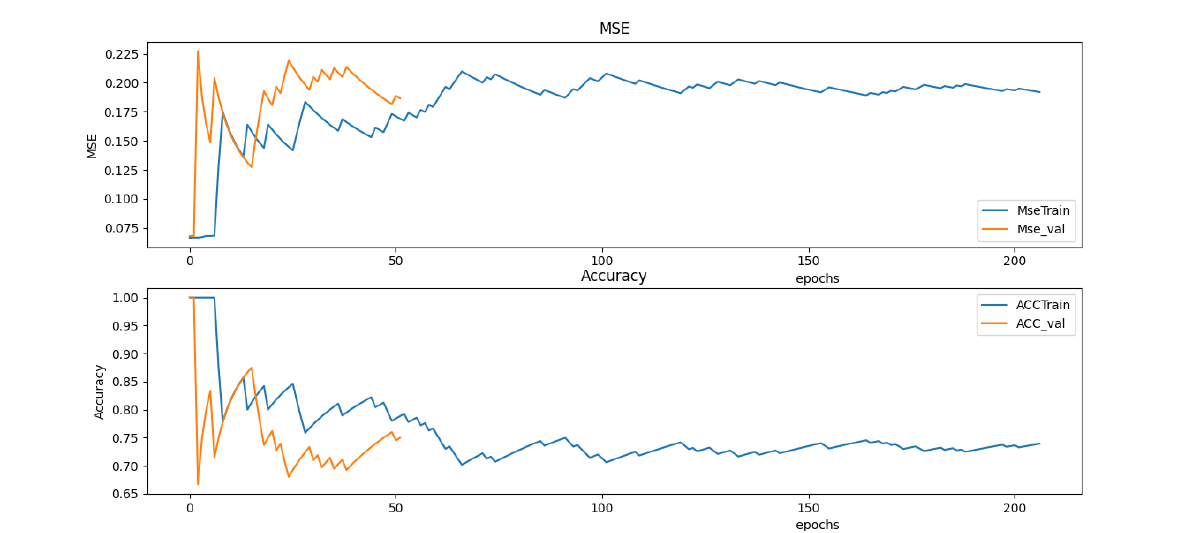
Figure 4. Machine learning algorithm shows increased accuracy and decreased MSE values over the first 50 training rounds (ie, epochs) for predicting MQOL and understanding skills of HL (Accuracy: 0.76, MSE: 0.17)